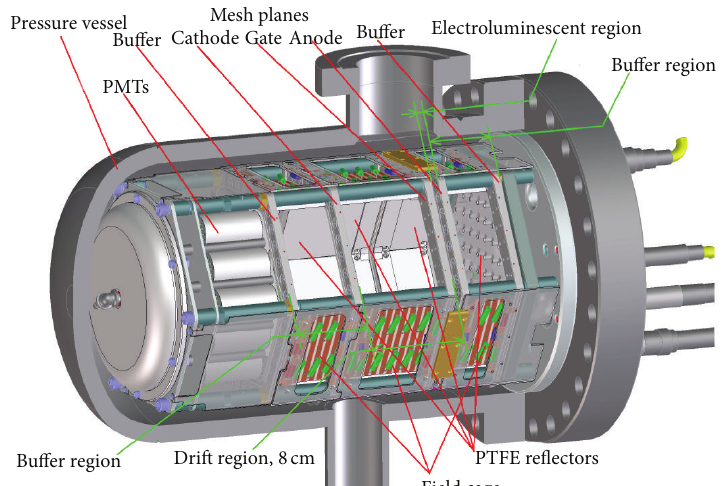
Figure 30: The NEXT-DBDM electroluminescent TPC configuration. An array of 19 photomultipliers (PMTs) measures S1 primary scintillation light from the 8cm long drift region and S2 light produced in the 0.5cm electroluminescence (EL) region. Two 5cm long buffer regions behind the EL anode mesh and between the PMTs and the cathode mesh grade the high voltages (up to ± 17 kV) down to ground potential.